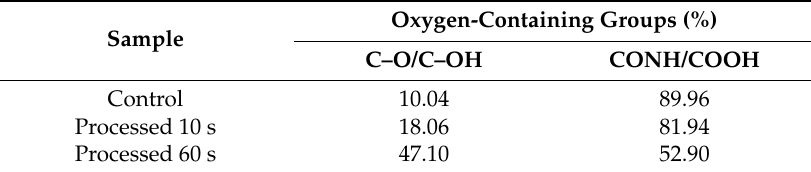
Table 3. Corresponding contents of various oxygen ‐ containing groups (%).